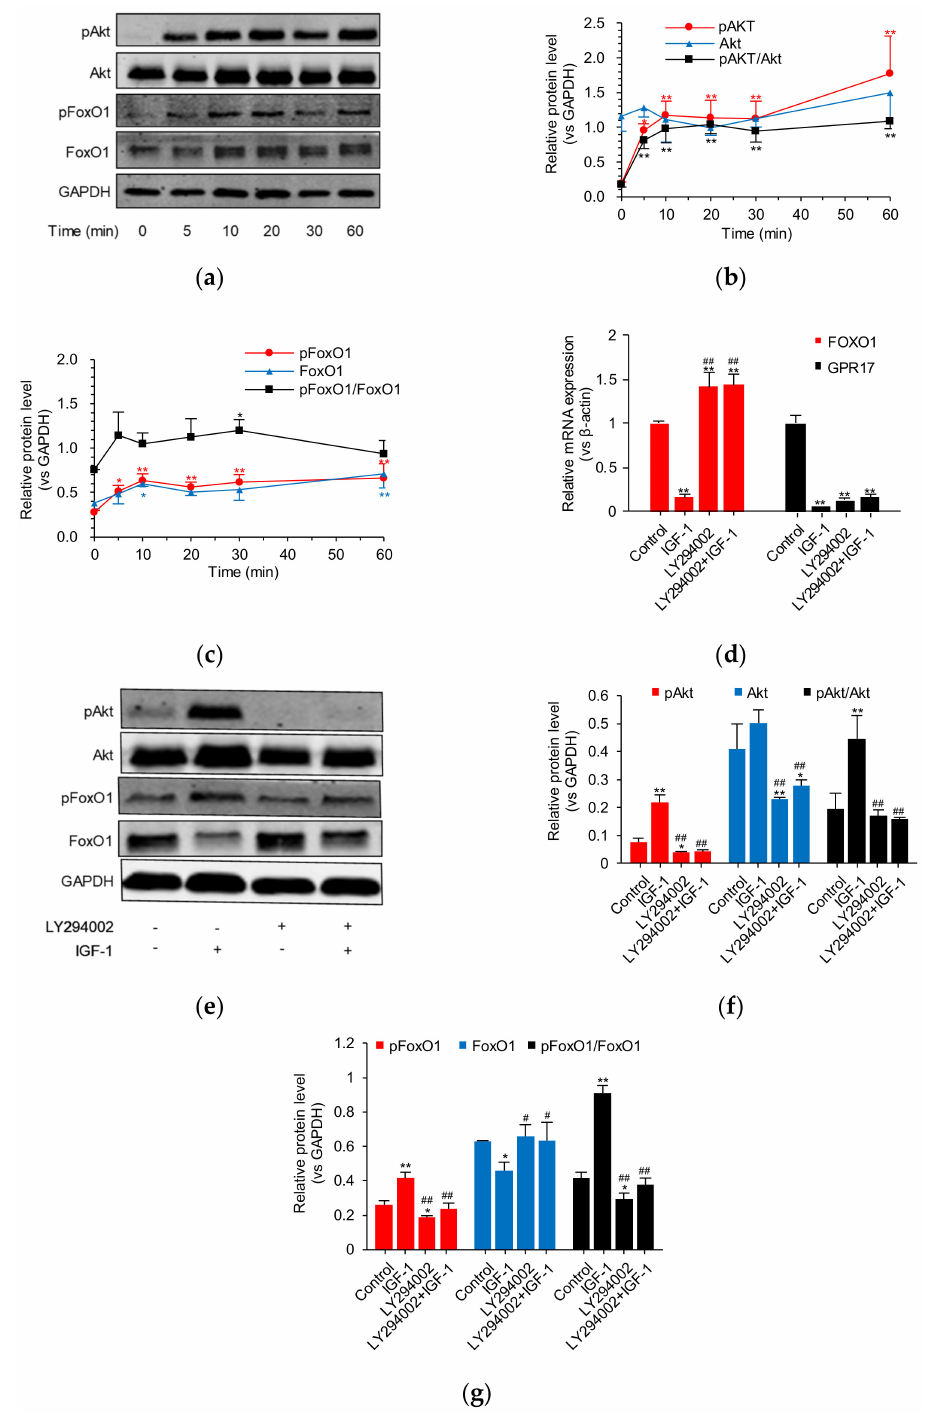
Figure 4. The influence of IGF-1 on PI3K/Akt/FoxO1-GPR17 signaling in SK-N-SH cells. ( a ) Western blot analysis of pAkt, Akt, pFoxO1, and FoxO1 protein expression in cells treated with 100 ng/mL of IGF-1 within 60 min; ( b , c ) quantification of pAkt, Akt, pFoxO1, and FoxO1 protein levels within 60 min; ( d ) levels of FoxO1 and GPR17 mRNA expressed in cells with or without IGF-1 and PI3K inhibitor (LY294002) treatment; ( e ) Western blot analysis of pAkt, Akt, pFoxO1, and FoxO1